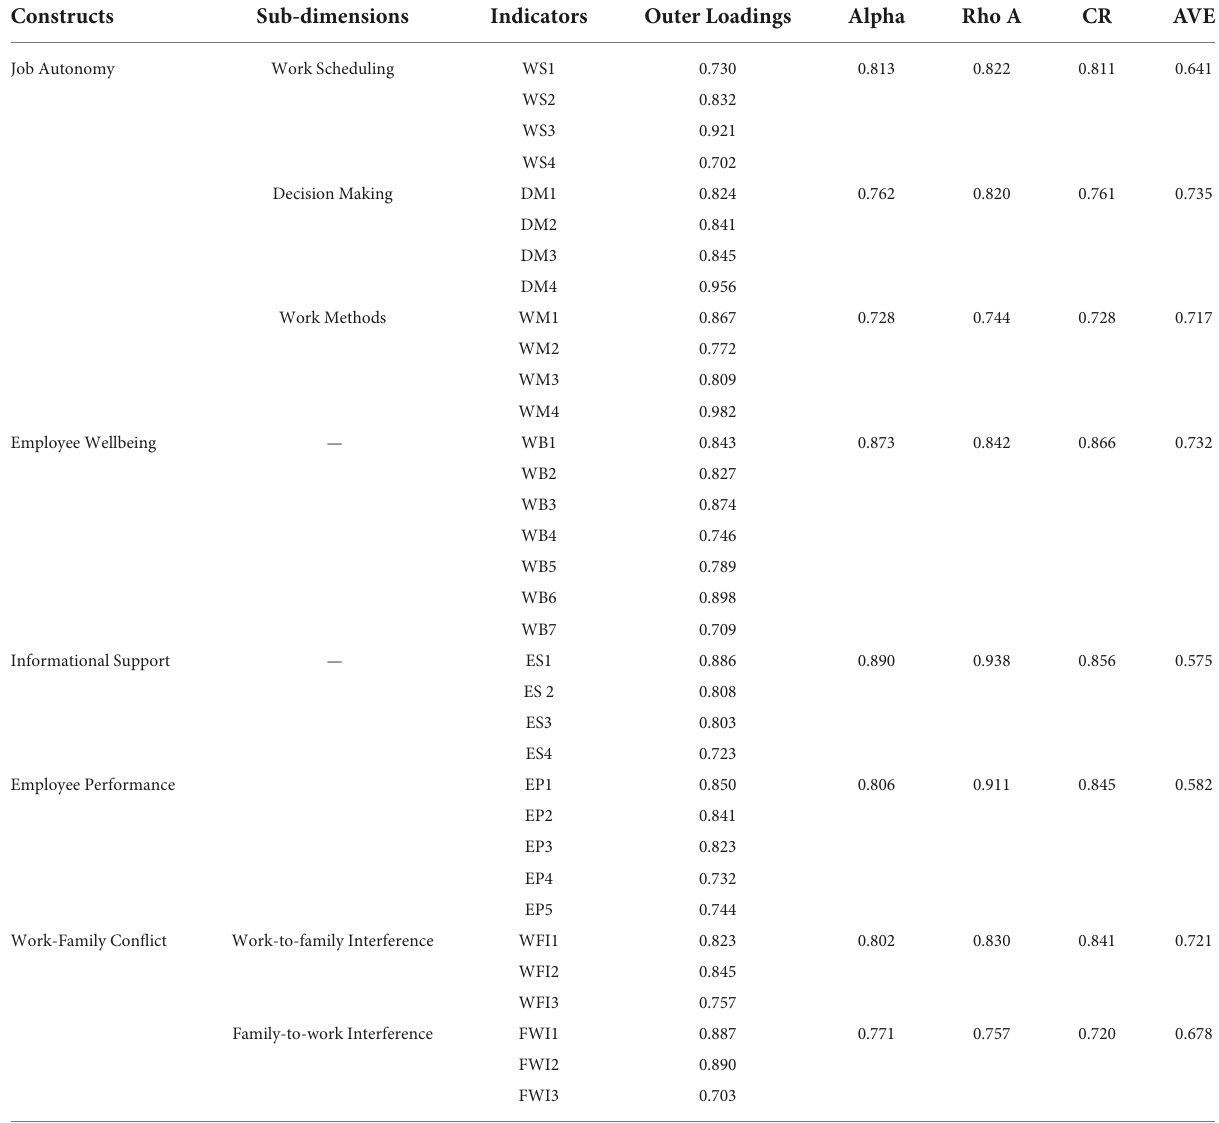
TABLE 1 Measurement model.